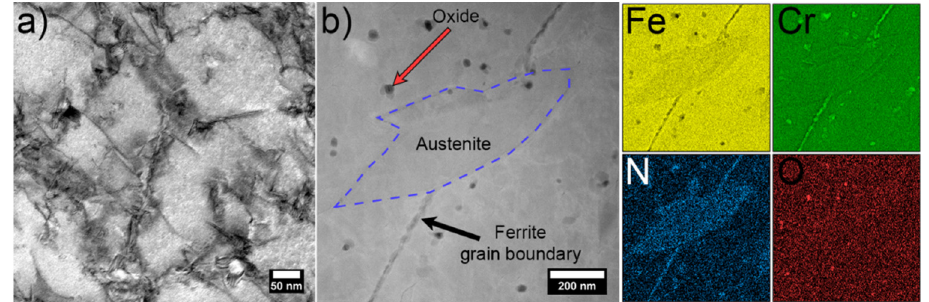
Figure 6. ( a ) BF STEM image of as-built SSS446 showing a high concentration of dislocations; ( b ) STEM Z-contrast image with a grain boundary and an austenite precipitate marked with blue dashed lines. The spinel grains within the ferrite grains are marked with a red arrow. Corresponding EDS maps are shown to the right.